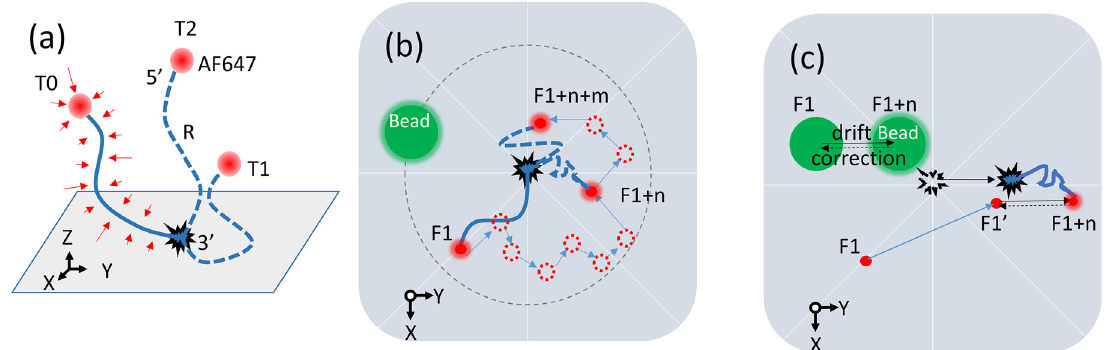
Figure 1: Illustration of confined stochastic motion of immobilized oligonucleotides in sequential imaging. (a) The 40-nucleotide oligomers, each of which is conjugated to a single AF647 (red dot) at 5 ′ end and to a biotin at 3 ′ end, are sparsely immobilized on gelatin-coated glass surface via biotin nonspecific binding. These oligonucleotide molecules are expected to exhibit sizes of around12 – 20nm(R),whicharewithinthesizerangeofmostbiomoleculesinregularcellsamplesforSTORM.Giventhenanometersizes,each oligonucleotide is subjected to random collisions (red arrows) from surrounding solution molecules and consequently undergoes con fi ned stochasticmotionwith one end fi xed at itsimmobilized site (blackstar). Inthis regard,each moleculeinimagingsolution keeps continuously andirregularlymovingwithinaconstrainedcycleregion,whichtakestheimmobilizedsiteascenterandRasradius(graydashedline).During the acquisition, the AF647 on each biomolecule would be stochastically activated, and its position can be recorded for determining localization of the entire biomolecule at different time points (e.g. T0, T1, T2, a), which are corresponding to different frames (e.g. F1, F1 + n , F1 + n + m ) in an image sequence (b). (c) Sample drift occurring during sequential imaging can be corrected with the use of fi xed fl uorescence bead that remains fl uorescent during the entire experiment ( fi lled green cycle). For example, the sample shifts during F1 to F1 + n (black solid arrow) can be corrected by comparing the position of bead at F1 and F1 + n (black dashed arrow). However, for the biomolecule, its position change is actually a combined effect of sample drift (black arrow) and con fi ned stochastic motion (blue arrow), and its corrected localization (F1 + n ’ )isdifferentfromtheoriginalpositionatF1.AF647;F1,frame(1);F1 + n ,frame(1 + n );F1 + n + m ,frame(1 + n + m